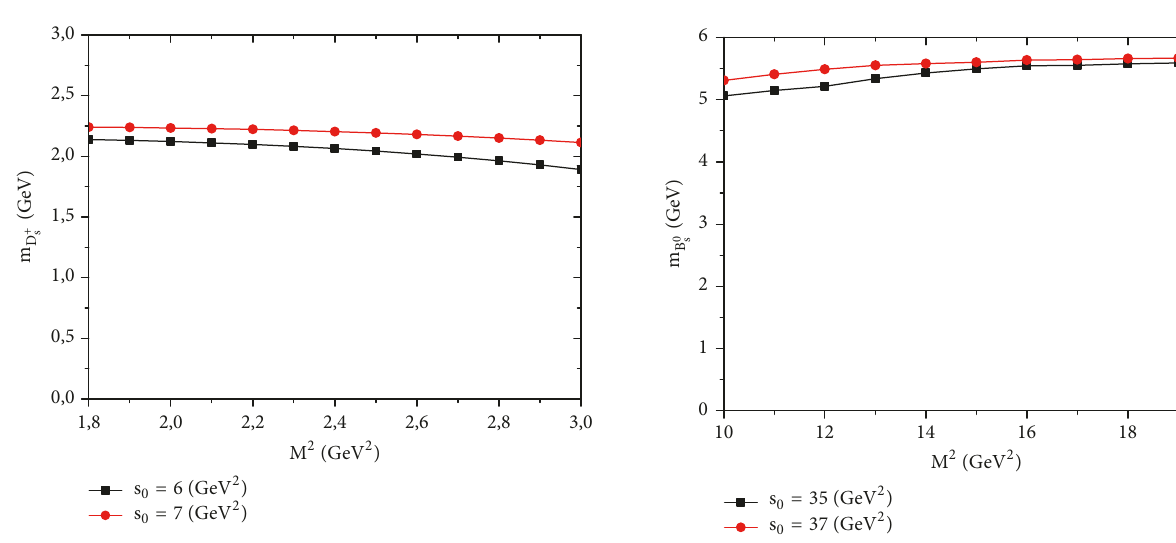
Figure 2: Borel parameter dependence of the 𝐷 + 푠 mass.